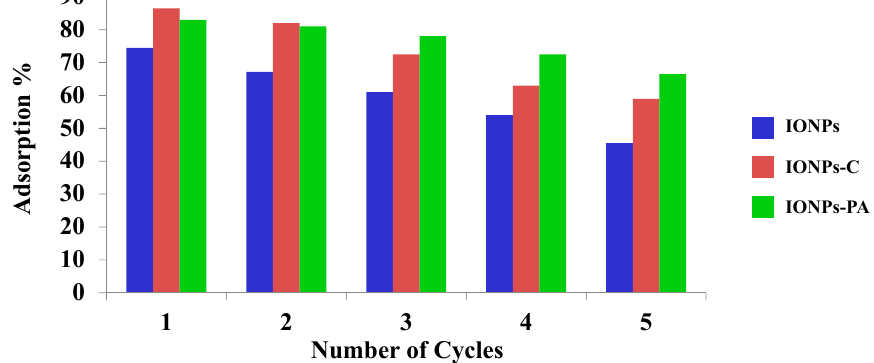
Figure 11. Adsorption cycles of adsorbents (IONPs; IONP-loaded chitosan and PVA–alginate nanocomposites).